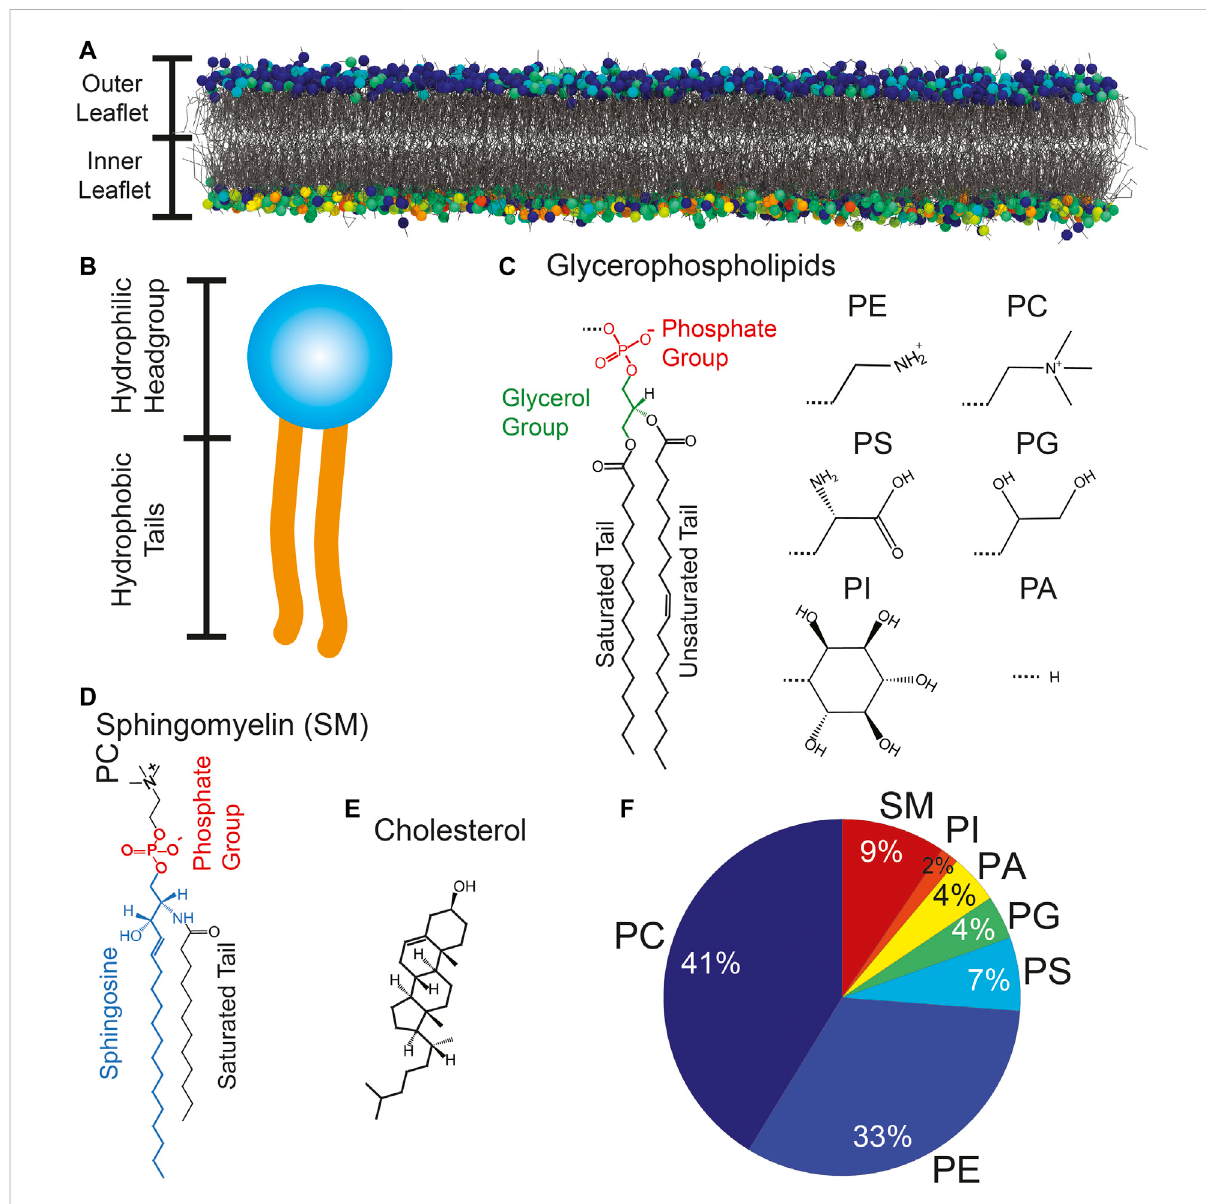
FIGURE 2 (A) The RBC cm is formed by two lea fl ets of lipids molecules. (B) Glycerophospholipids and sphingomyelin consist of a hydrophilic head group and two hydrophobic tails. (C – E) Chemical structures of glycerophospholipids, sphingomyelin and cholesterol. Common head groups